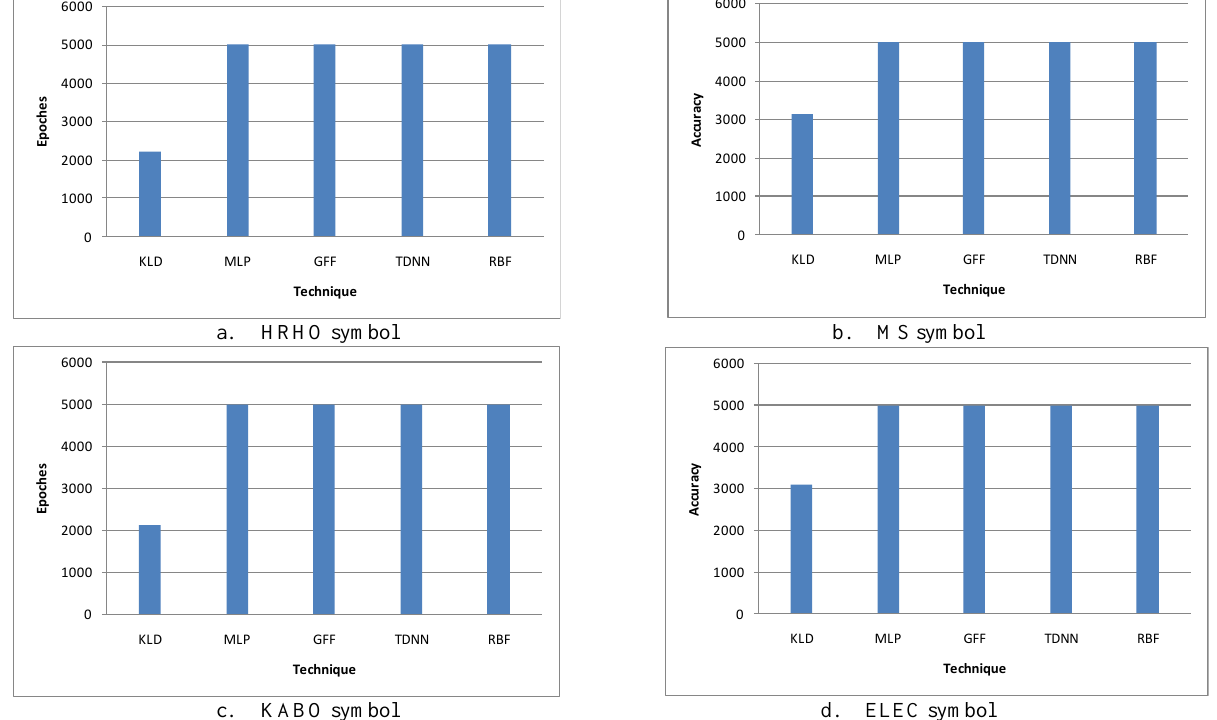
Fig. 10. Performance analysis of the proposed